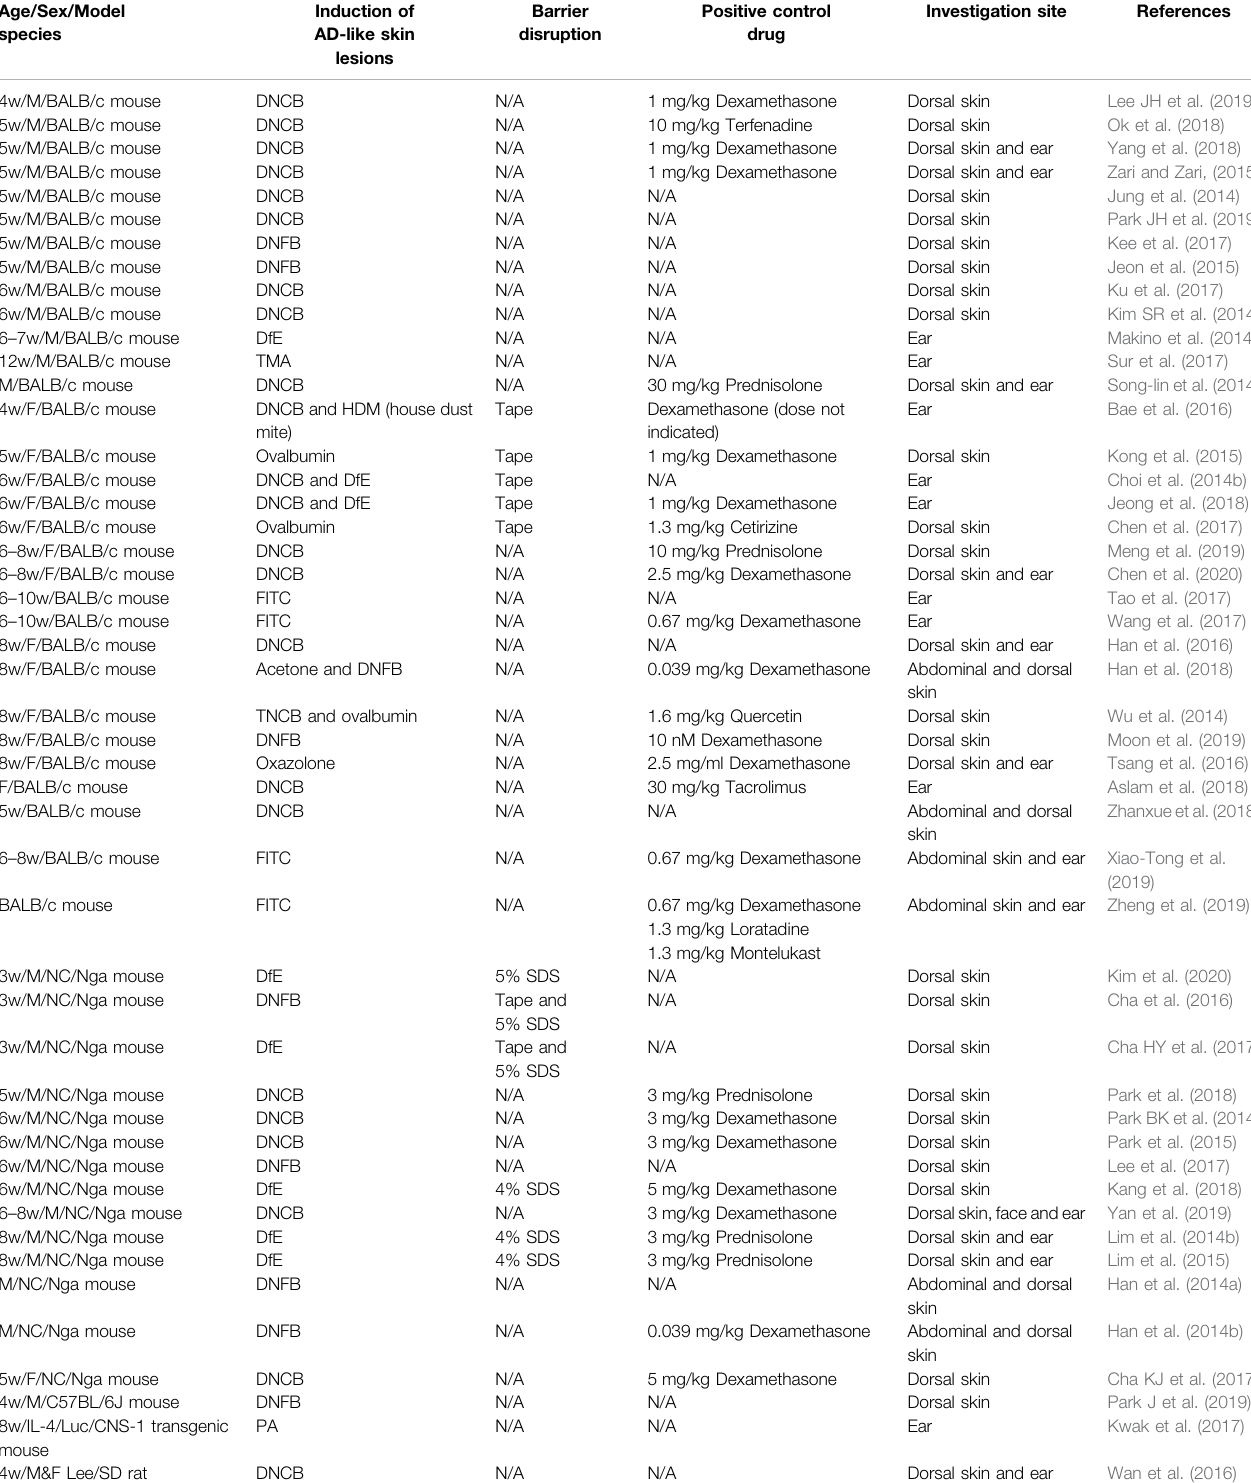
TABLE 2 | Basic characteristics of the murine models and experimental procedures from studies involving oral treatments of herbs and their active constituents. Age/Sex/Model